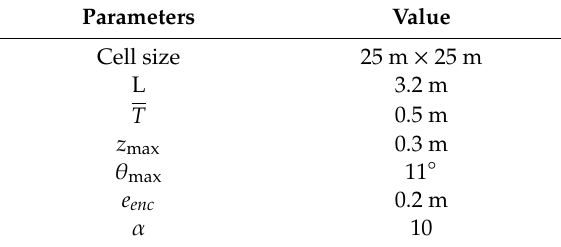
Table 6. Table of Related parameters.